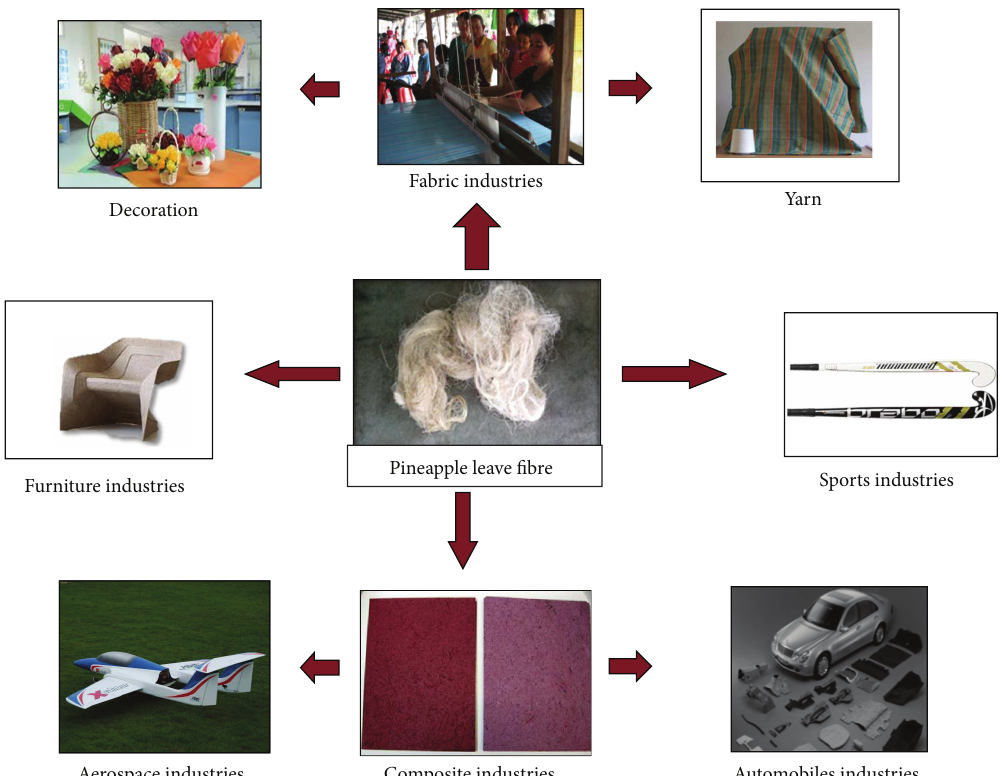
Figure 3: Various present and future applications of pineapple